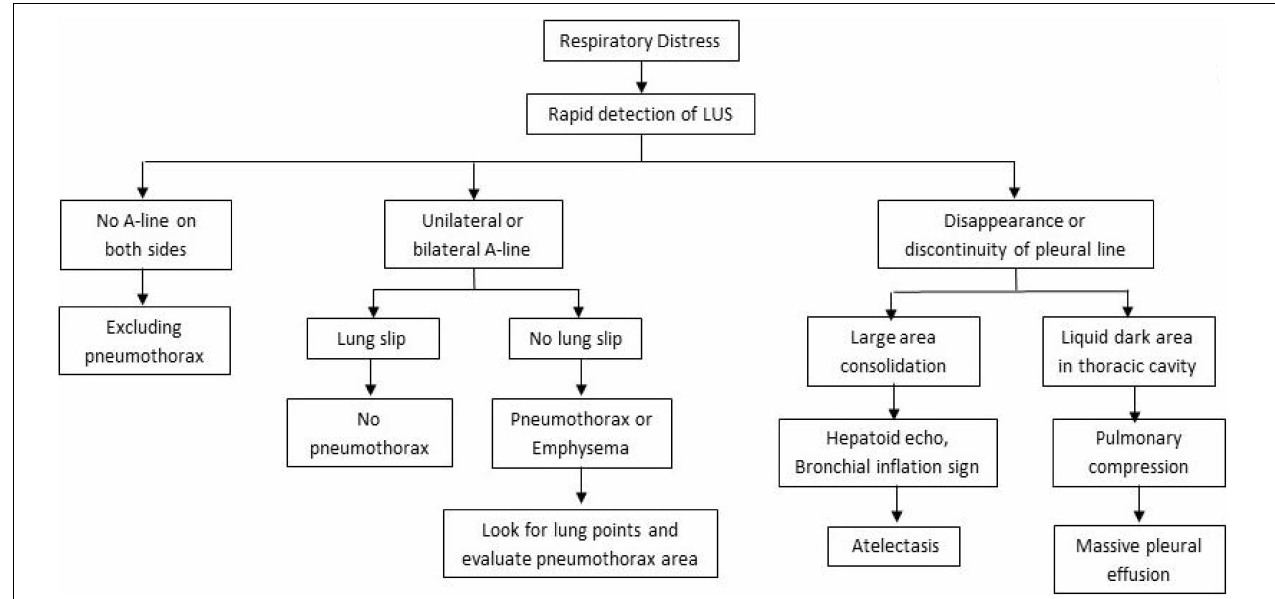
FIGURE 7 | Process of rapid detection of respiratory distress by